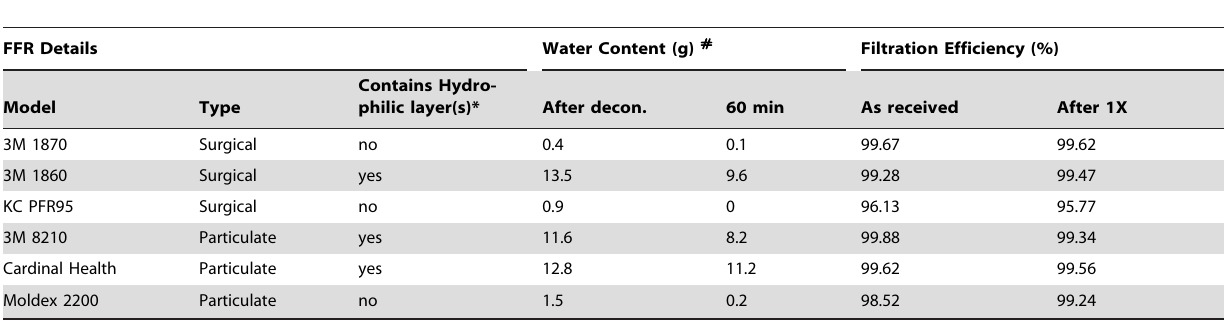
Table 1. Phase 1 screening of FFRs for water absorbency and filtration